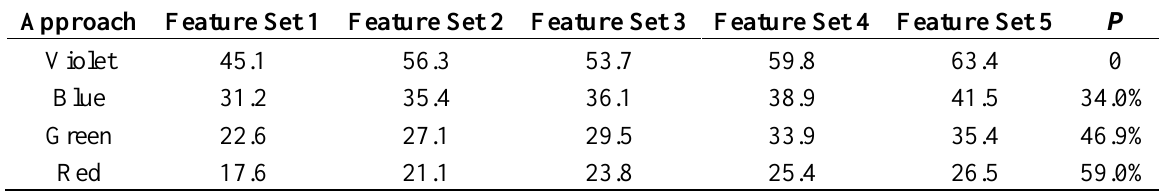
Table 3. Average homing errors. Feature sets 1–5 correspond to the features stored at the nodes and obtained during the above five types of experiments. Compared with the standard SURF (violet trajectory), P denotes the percentage by which the homing error has been lowered through the five feature